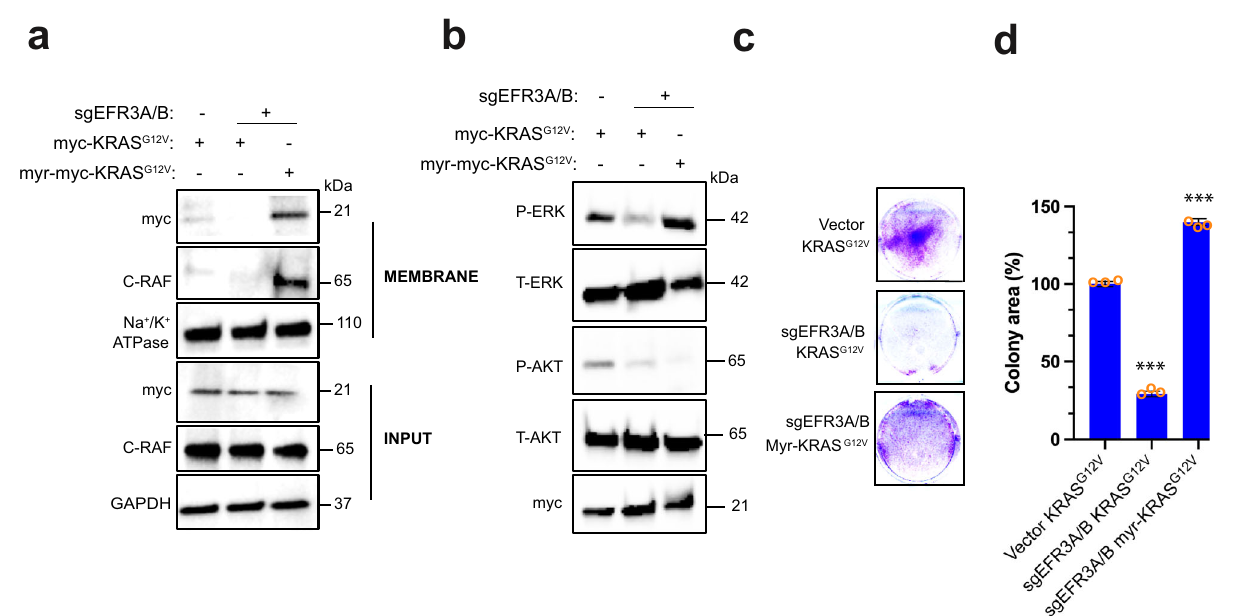
Fig. 7 KRAS membrane anchoring rescues signaling and transformation defects in EFR3A-null cells. a – d Immunoblot analysis of ( a ) membrane fraction for myc-KRAS G12V , myr-myc-KRAS G12V , C-RAF, Na + /K + ATPase, and GAPDH, and ( b ) phosphorylated (P) and total (T) ERK and AKT, and ( c ) an example of colony formation, as assessed by crystal violet staining, which is ( d ) plotted as mean ± SD of colony area, for human HEK-HT cells stably infected with a lentivirus encoding Cas9 encoding no sgRNA (vector) or sgEFR3A/B in the absence and presence of ectopic myc-KRAS G12V or when targeted to the PM by an N-terminal myristoylation sequence (myr-myc-KRAS G12V ). INPUT levels of indicated proteins serve as loading controls. a , b Representative of 3 biological replicates. c , d Representative of 3 biological replicates tested in triplicate. Replicate experiments and full-length gels are provided in Supplementary Fig. 13. Signi fi cance values were calculated by one-sided student ’ s t test for ( d ): *** p < 0.001. Speci fi c p values for ( d ) are 0.00027 (KRAS G12V sgEFR3A/B ) and 0.00022 (myr-KRAS G12V sgEFR3A/B